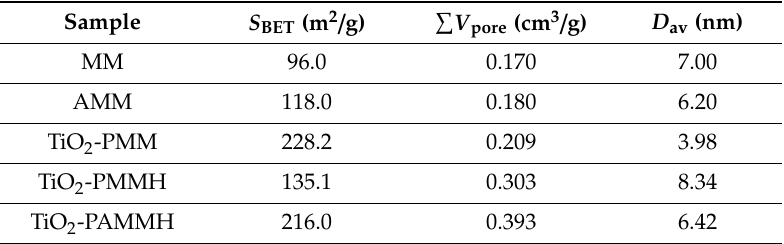
Table 1. Textural characteristics of the original and modified MM samples.